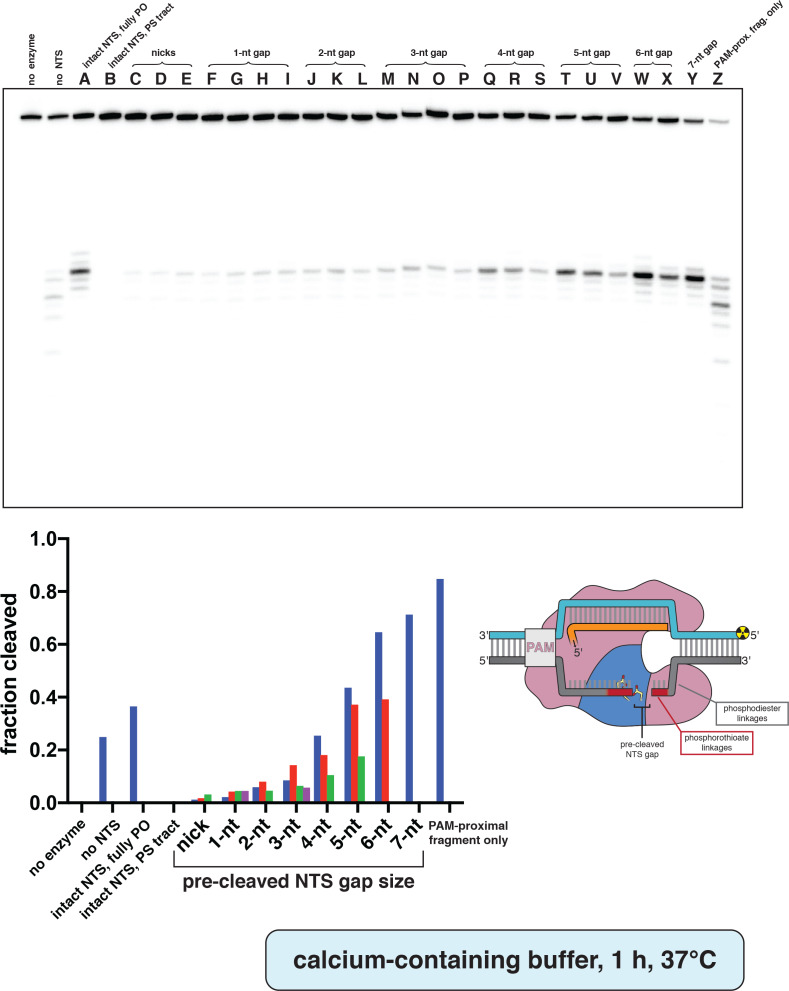
Phosphorimage and quantification of non-target-strand gap-dependence experiments, in CaCl2.Experiment was performed as described in legend to Appendix 2—figure 2A. Substrates indicated by a letter are as schematized in Appendix 2—figure 2—figure supplement 4. When a given category has more than one substrate (e.g., 3-nt gap includes substrates M, N, O, and P), the first listed substrate (M) is shown as a blue bar, the second (N) as a red bar, the third (O) as a green bar, and the fourth (P) as a pink bar. ‘Fraction cleaved’ is defined as (sum of the volume of all bands below the uncleaved band)/(total volume in lane).